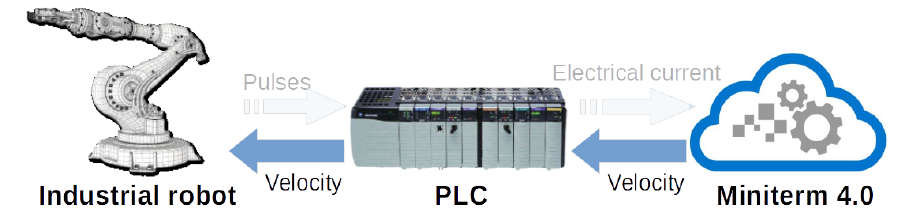
Figure 11. Experimental setup. Electrical current measurement is optional for the success of the rebalancing